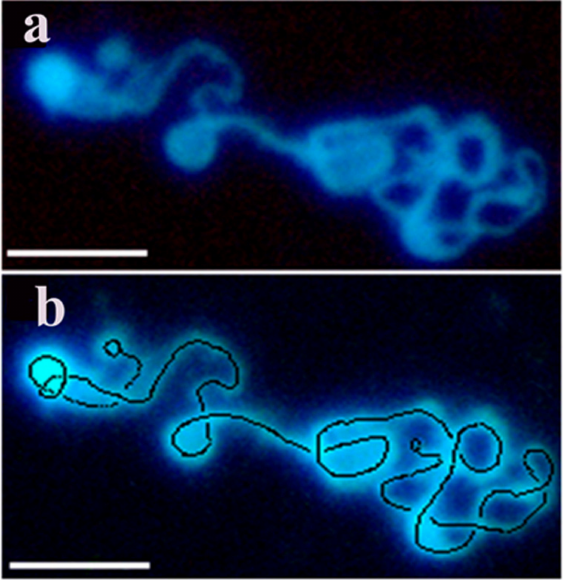
Figure 5. The continuous backbone of the decondensed chromosome of CHO-K1 is traced with a dotted black line and its two ends are indicated by small back circles. Decondensed chromatin fiber was isolated from reversibly permeabilized CHO cells. ( a ) Isolation and visualization of the linear array of chromatin were performed as described in the Methods. ( b ) The same c chromatin structure is indicated by the continuous line and the two ends of the nuclear material. Bars, 5 µ m each. Modified with permission from Ref. [30]. Copyright year 2009, Springer, Dordrecht. Figure 3.14 of this